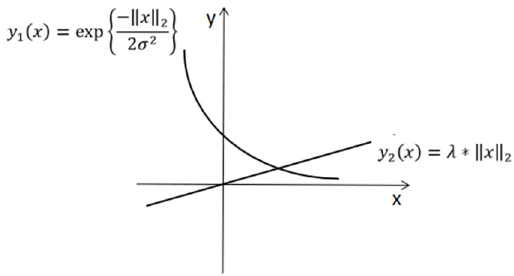
Figure 3. The change trend of the Gaussian kernel function and the penalty term function. Based on above, the detailed process of neighborhood segmentation is as